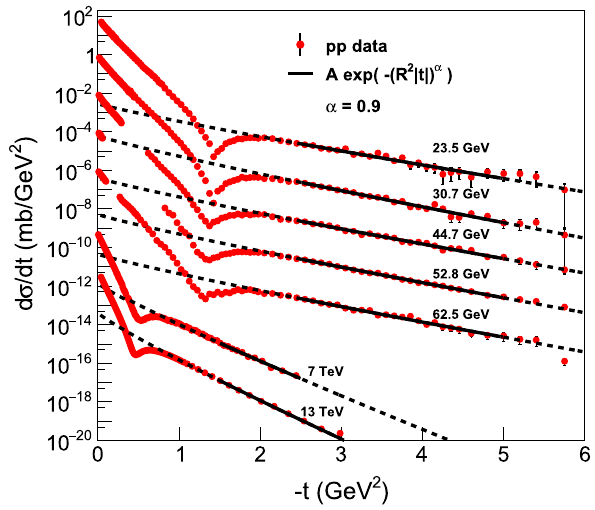
Fig. 6 Summary plot of the Lévy fits, d σ/ dt = A exp ( − ( R 2 | t | ) α ) to the tails of the elastic pp scattering data at ISR and LHC energies rang- √ s = 23 . 4 GeV up to 13 TeV, with α = 0 . 9 fixed. Solid black ing from lines indicate the fitted region, in each case the CL is in the acceptable 99 . 9% > CL > 0 . 1% range. Dashed line indicates an extrapolation outside the fitted region. These results are detailed in “Appendix C” and further explained in terms of a proton substructure in Sect. 3.4. The dashed lines continue the fitted, solid curves outside the fitted region, to improve the clarity of the presentation